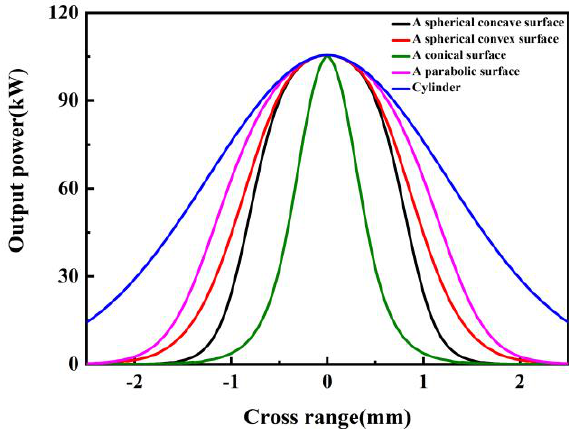
Figure 5. Predicted peak radial intensity distribution.